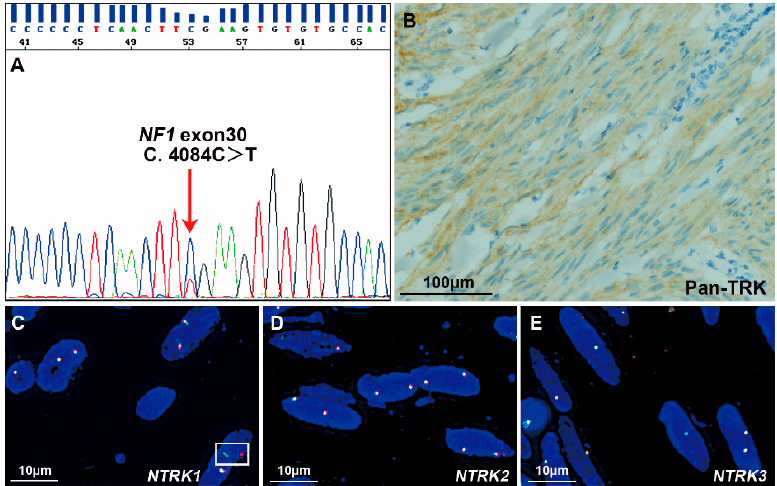
Figure 4. A NF1 -related GIST with weak-moderate expression of Pan-TRK (case #3). ( A ) Sanger sequencing indicated a heterozygous point mutation in exon 30 of the NF1 gene (c.4084C > T, p.Arg1362*). ( B ) IHC staining showed weak-moderate cytoplasmic expression of Pan-TRK (400×). Scale bar is 100µm. ( C – E ) FISH images obtained using NTRK1 , NTRK2 , and NTRK3 break-apart